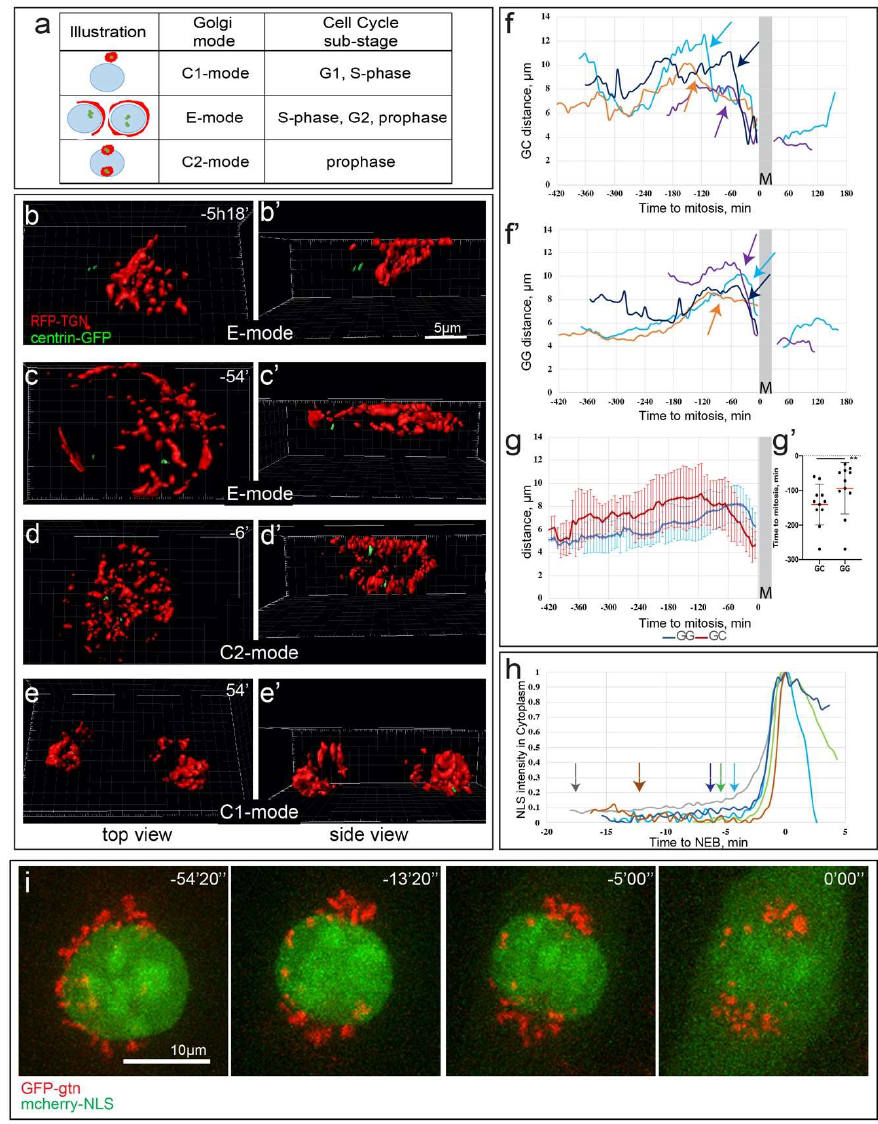
Figure 2. Dynamics and timing of Golgi configuration modes in living cells. ( a ) Model of Golgi mode progression aligned with cell cycle progression. ( b – e’ ) Frames from a time-lapse imaging sequence of RPE1 cells stably expressing Golgi (RFP-TGN, red) and centrosome markers (centrin1-GFP, green). Corresponding Golgi configuration modes: C1-E transition ( b , b’ ), E ( c , c’ ), C2 ( d , d’ ), C1 ( e , e’ ). 3D reconstructions of spinning disk confocal stacks (top-down views ( b – e ) and side views ( b’ – e’ )). Time, hours, minutes. ( f ) GC and ( f’ ) GG distance profiles for 4 representative cells over time. Time point “0” indicates the beginning of cell division. ( g ) Averaged GC (red) and GG (blue) profiles over time. Sequences aligned by the beginning of cell division (time point “0”). n = 9. Error bars, SD. Note the declines of the curves prior to cell division. ( g’ ) Time when GC (left) and GG (right) reach maxima before beginning to decline prior to cell division. Data for individual cells analyzed in ( g ). Note that GC peak is significantly earlier than GG. n = 9. Red line, mean. Error bars, SD. Student’s t -test, ** p < 0.01. ( h ) Intensity profiles for NLS signal in the cytoplasm of individual cells prior to and during nuclear envelope breakdown. Based of imaging as in ( i ). C2 mode onset times are indicated by arrows. n = 5. ( i ) Frames from a time-lapse imaging sequence of RPE1 cells transfected with GFP-gtn (pseudo-colored red) and mCherry-NLS (pseudo-colored green). Note Golgi compaction at –13 (cid:48) 20 (cid:48)(cid:48) and –5 (cid:48) 00 (cid:48)(cid:48) and NLS leakage into the cytoplasm at 0 (cid:48) 00 (cid:48)(cid:48) . Scale bar, 10 µ m. Time, minutes, seconds. Images are maximum intensity projection of entire spinning disk confocal